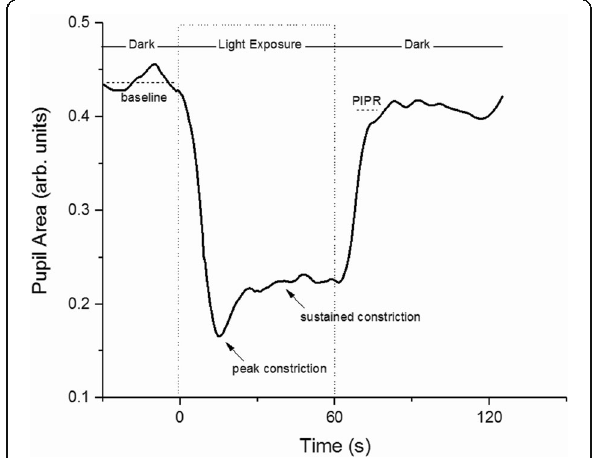
Fig. 2 A representative tracing of pupil area as it changes in response to a sixty-second light exposure that is preceded and followed by darkness. In each exposure, we quantitate the baseline in darkness, the peak constriction, the sustained constriction,